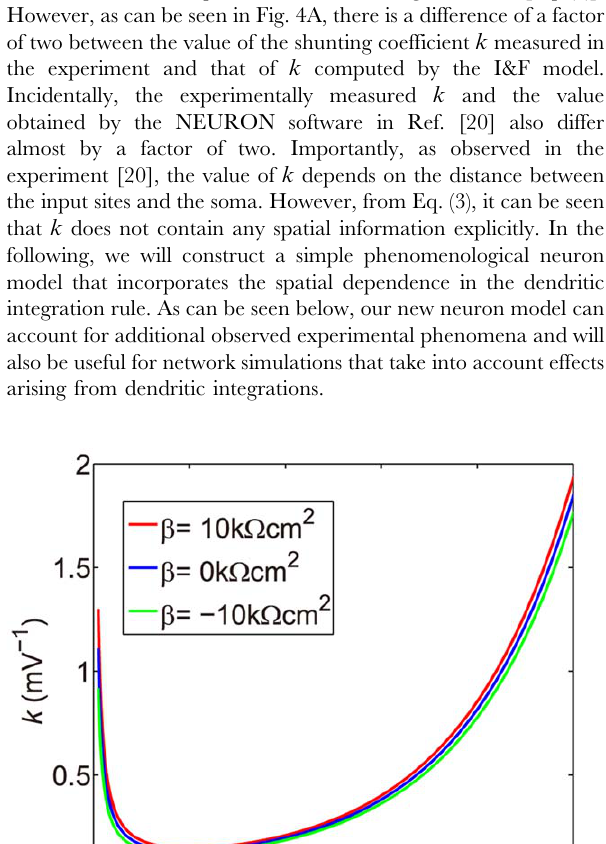
Figure 4. Dendritic integration rule obtained from the I&F model (A–C) and the modified I&F model (D–F). We choose the values of a ~{ 8k V : cm 2 and b ~ 7k V : cm 2 so that the value of k computed from Eq. (8) matches the value measured in the experiment [20]. Lines in figures indicate linear fits with slope k . (A) Ratio between SC and EPSP (SC/EPSP) plotted against IPSP (red square online) and SC/IPSP plotted against EPSP (blue circle online) at time t (cid:2) for the I&F model (Red online: k =0.070; blue online: k ~ 0 : 065 ). Inset: experimental measurement (Red online: k =0.142; blue online: k ~ 0 : 145 ). (B) Ratio between the mean SC and the mean EPSP (SC/EPSP) plotted against the mean IPSP (red square online), the mean SC and the mean IPSP (SC/IPSP) plotted against the mean EPSP (blue circle online) for the I&F model. Inset: experimental measurement. (C) the same as (A) but at time (1) t =20 ms, (2) t =40 ms, (3) t =60 ms and (4) t =80 ms, respectively, as marked on the figures. (D) the same as (A) but for the modified I&F model (Red online: k =0.147; blue online: k ~ 0 : 143 ). Inset: the same as the inset of (A). (E) the same as (C) but for the modified I&F model. (F) the same as (B) but for the modified I&F model. Inset: the same as the inset of (B).